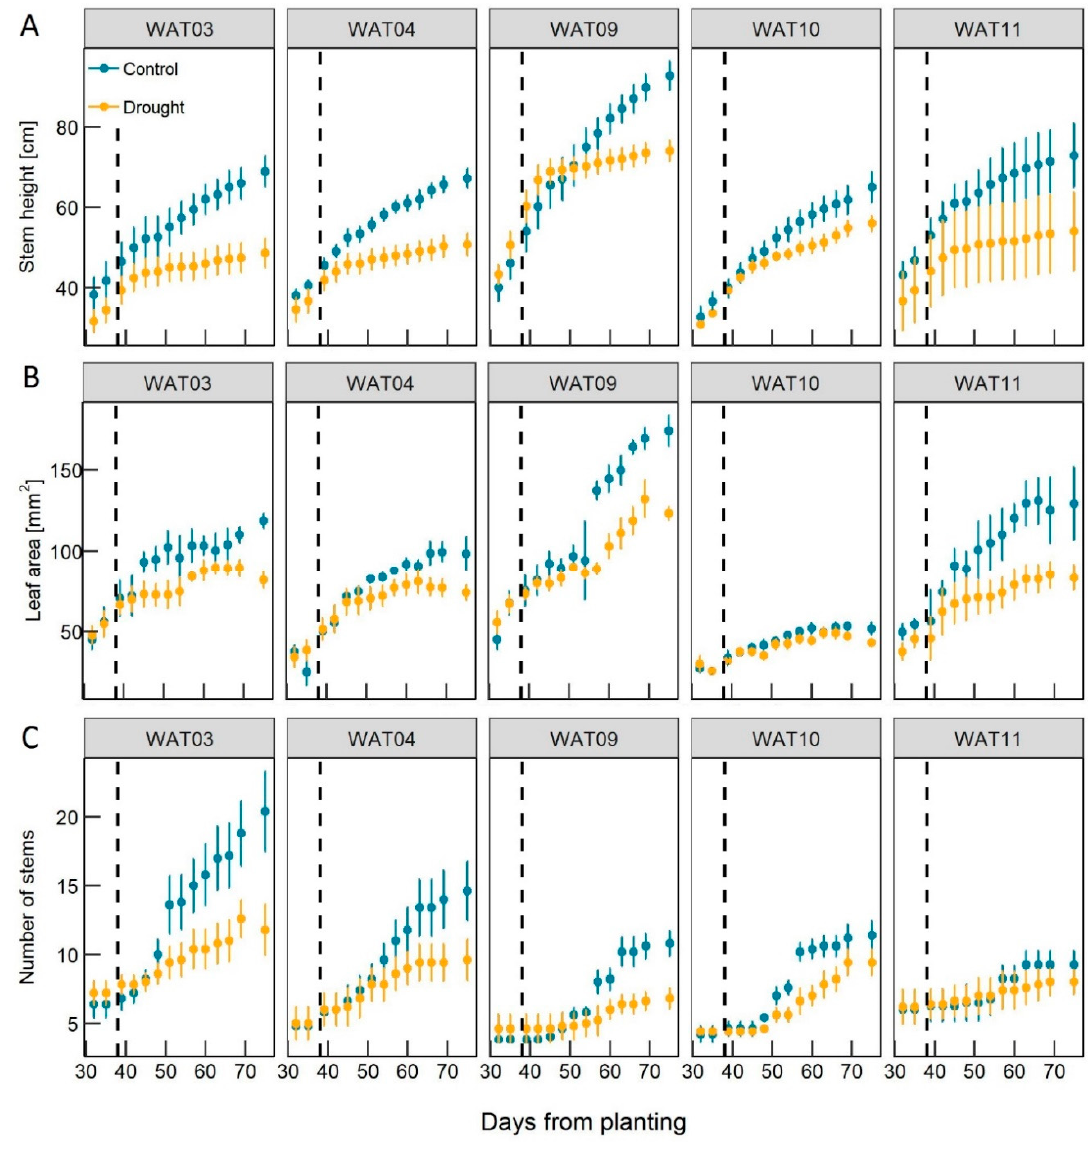
Figure 2. Above-ground morphology characteristics. The main stem elongation ( A ), youngest fully expanded leaf area development ( B ), and increase in stem number ( C ) curves for control and drought treatments of five genotypes. The dashed vertical line indicates the onset of drought stress. Values represent means ± SEM ( n = 5); SEM—standard error of the mean.